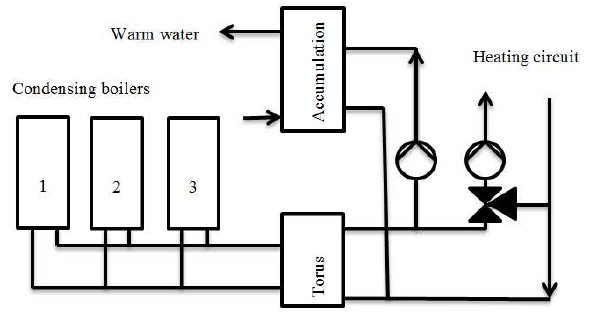
Fig. 2. Simplified diagram of 2016